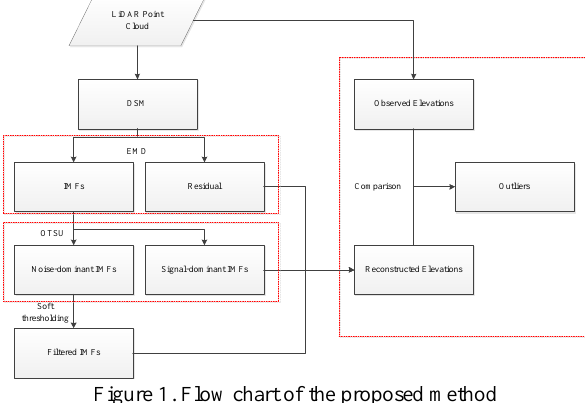
Figure 1. Flow chart of the proposed method